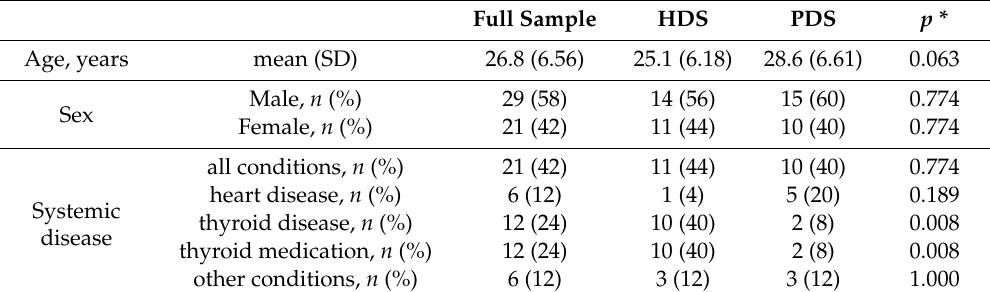
Table 1. Patient sample characteristics (age, sex and systemic conditions) for the entire sample and for those with Down syndrome and periodontitis or a healthy